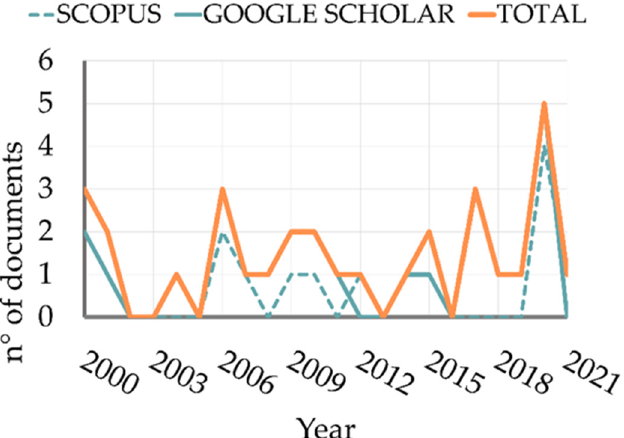
Figure 4. Number of papers by year after the refine diversified by different colours: blue dashed line for Scopus, blue solid line for Google Scholar and orange line for the total number of documents.